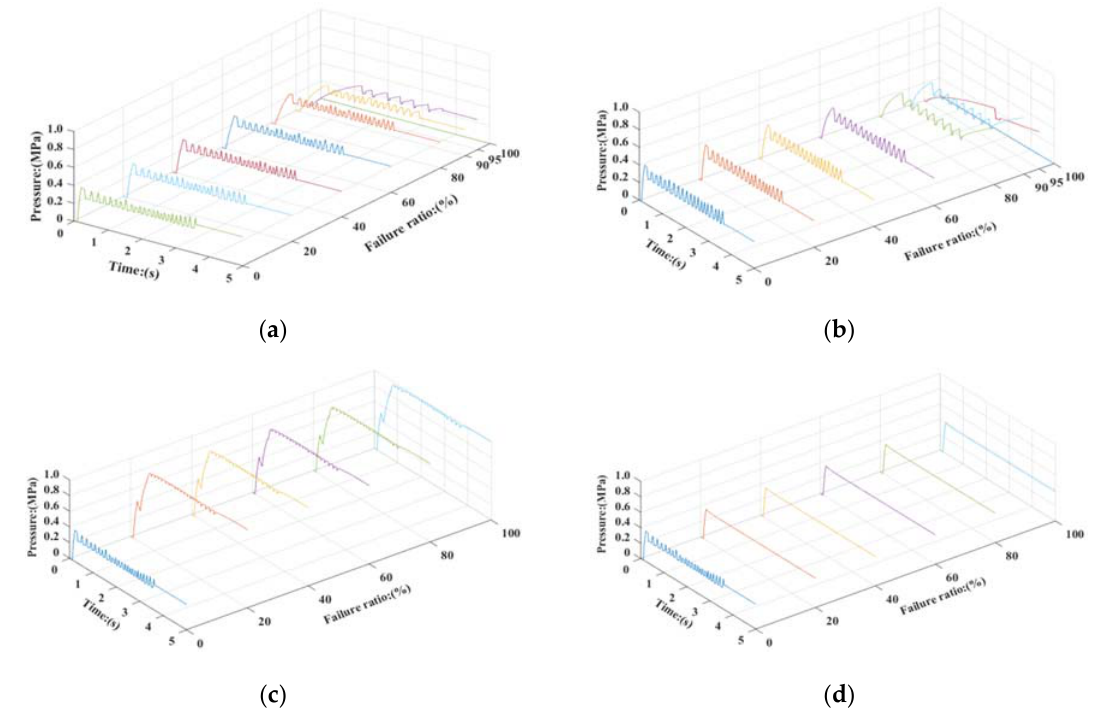
Figure 24. Pressure of brake chamber of different failure ratios. ( a ) mode 1 (FL); ( b ) mode 2 (RL); ( c ) mode 3 (FL); ( d ) mode 4 (FL).